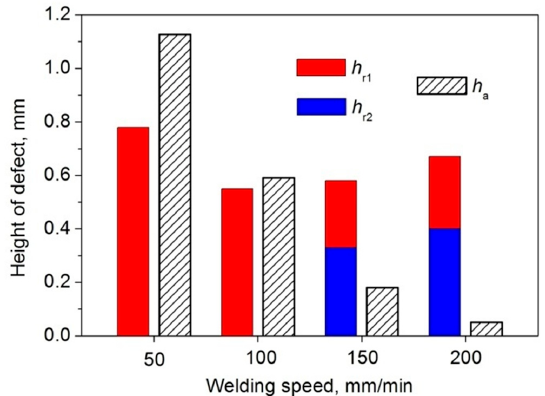
Figure 5. Height values of the hook and cold lap defects formed at different welding speeds; h a refers to the height of the hook defect at AS, while h r1 and h r2 represent the heights of the cold lap defects in the top and bottom sheets at RS, respectively.